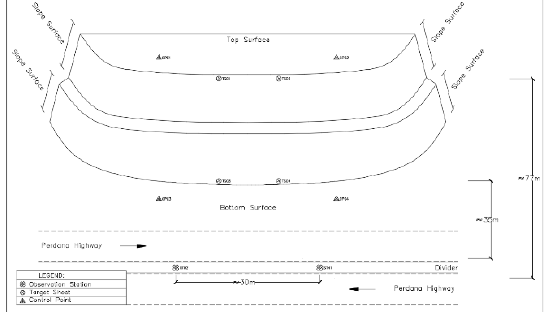
Figure 8. Overall layout of the control points and observation stations